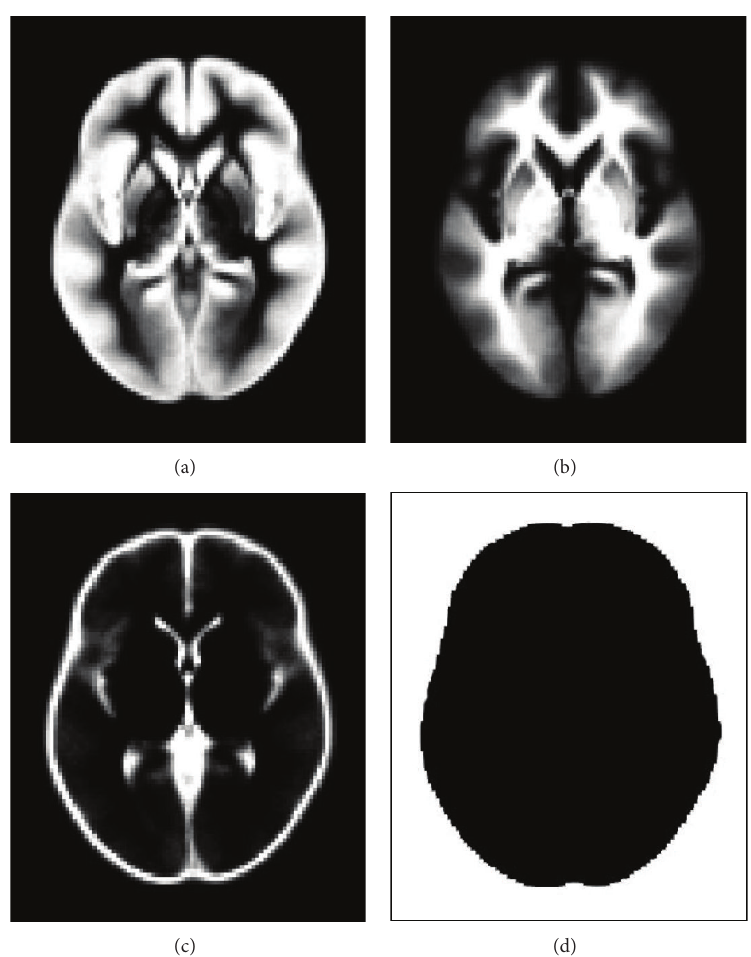
Figure 3: The tissue probability of the template for (a) gray matter, (b) white matter, (c) CSF, and (d) “others,”